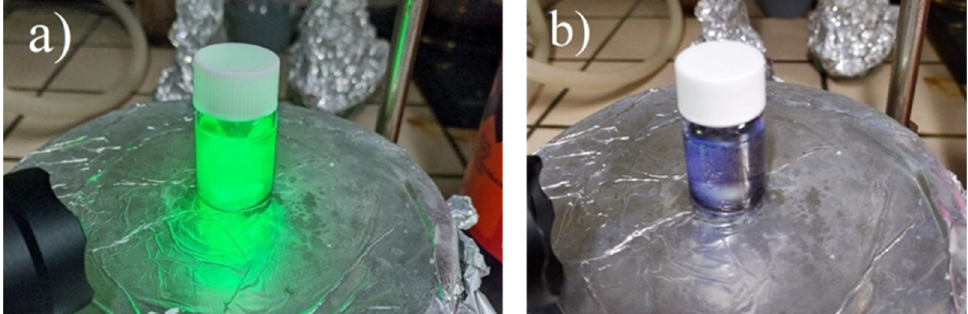
Figure 5 . Photographs under UV light (375 nm) of the CsPbBr 3 NCs dispersion ( a ) before and ( b ) after the introduction of nanoporous gold.